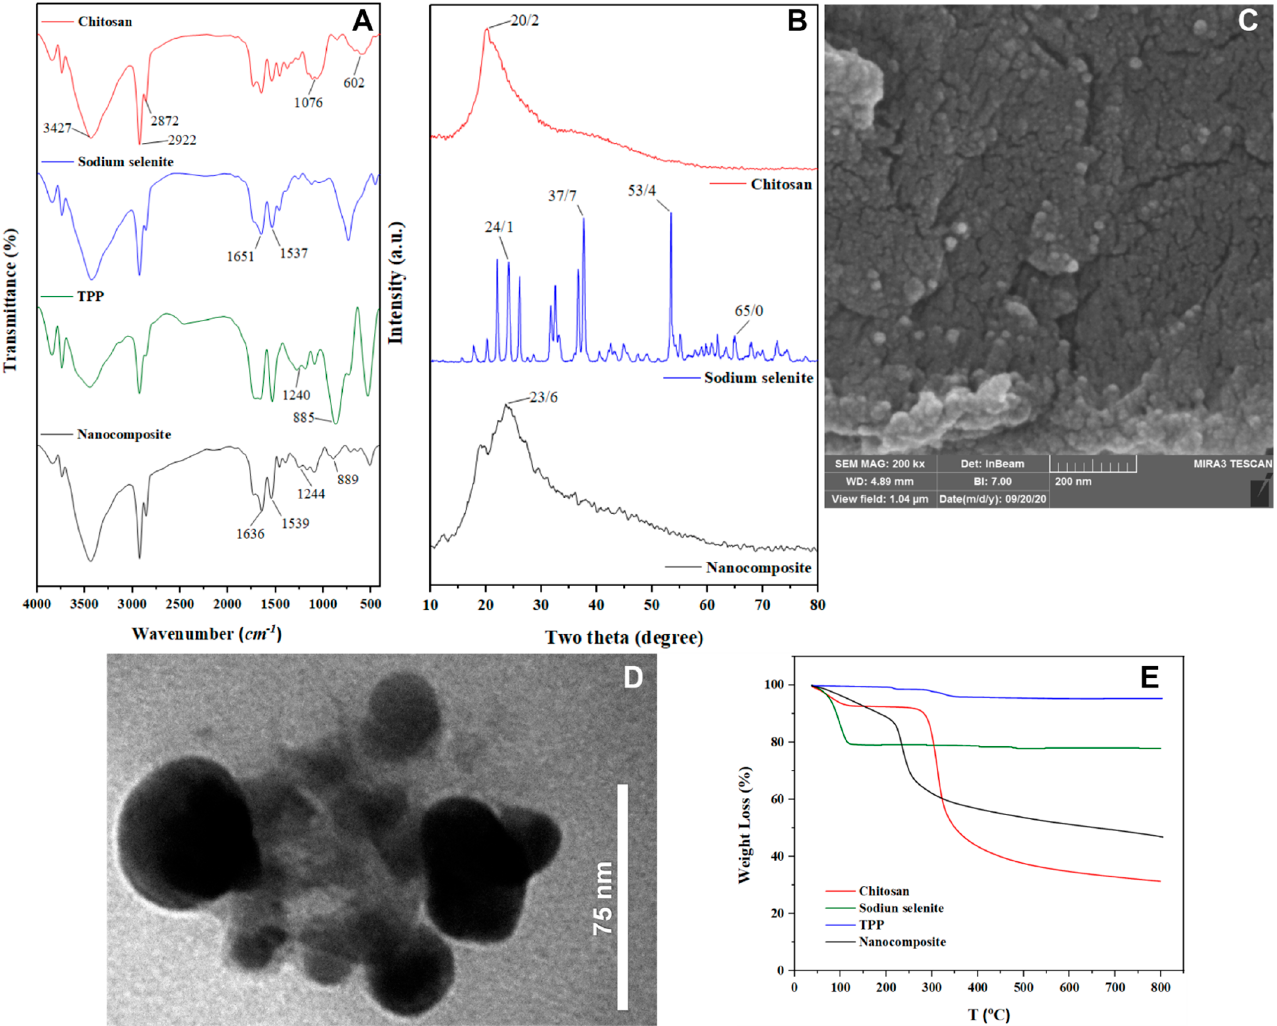
Figure 1. FT-IR ( A ), XRD ( B ) SEM ( C ), TEM ( D ) and TGA ( E ) analysis of starting materials and chitosan-selenium nanoparticles (Cs–Se NPs).